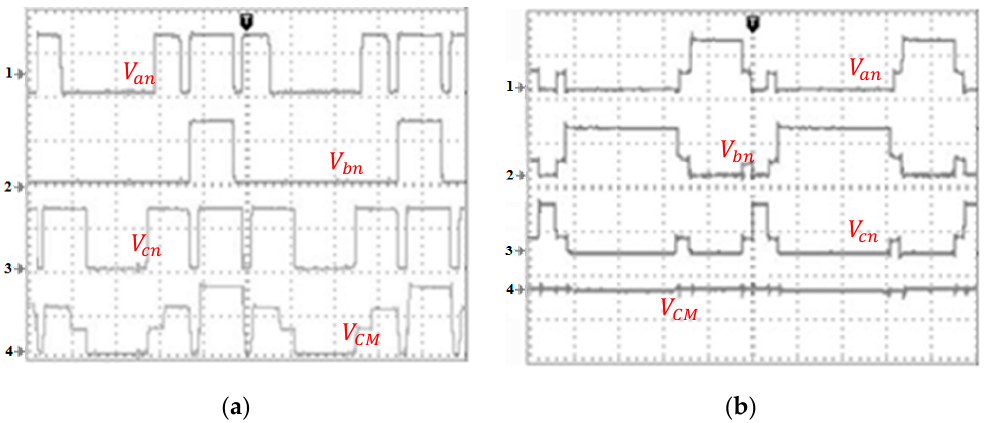
Figure 13. Three phase output voltage and CMV waveforms (100 volts / div and 10 µ s time / div): ( a ) SPWM method; ( b ) proposed approach.